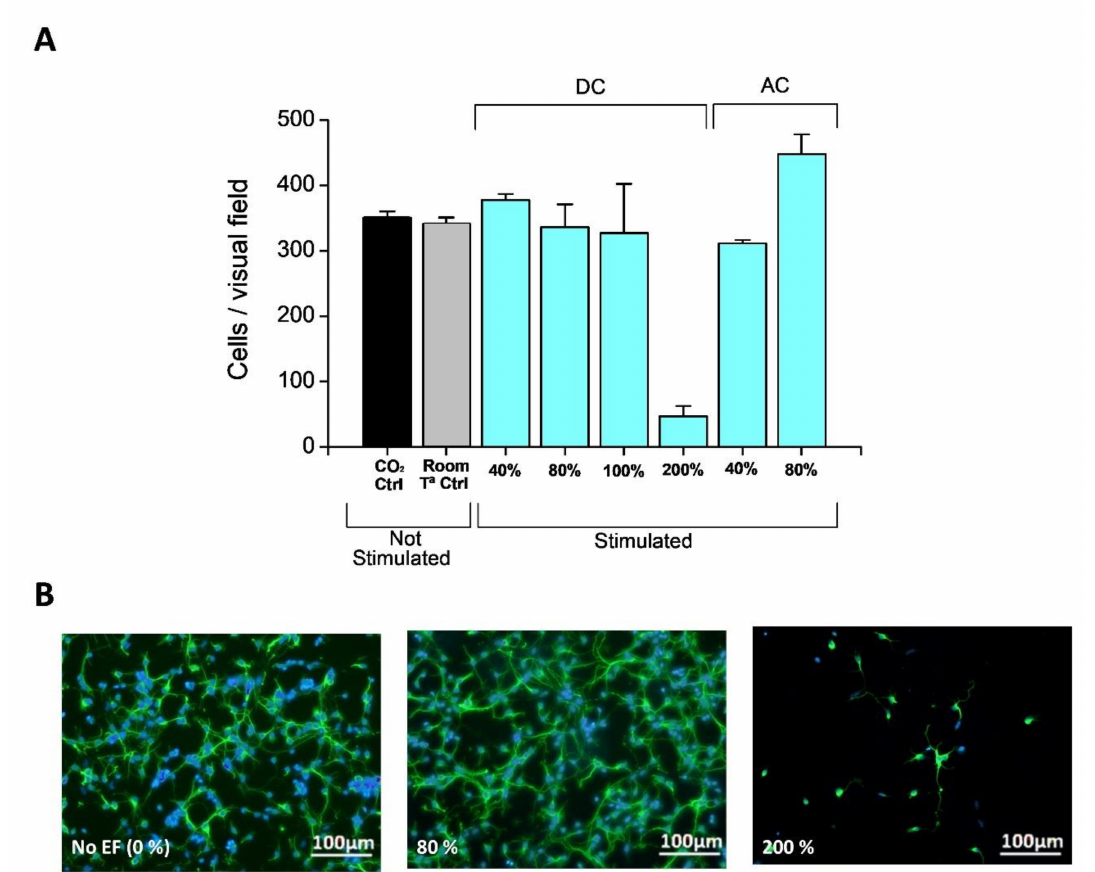
Figure 12. ( A ) Quantification of neural cell growth in absence and presence of EF with Q delivered below (80% of the total CSC) and above CSC (based on Tau imunostaining of scratched cortical neuron cultures showing spontaneous regeneration of surface covered by new neurites after scratching the neuronal monolayer at 5 DIV in each case) [34]. ( B ) Representative images of cell growth with no field and using (80% and 200% of the CSC value for the charge delivery). ( B ) Neurite and nuclei images for comparison (Cells were processed for Tau inmunocitochemistry and Bis-benzimide staining of the nuclei). With permission from